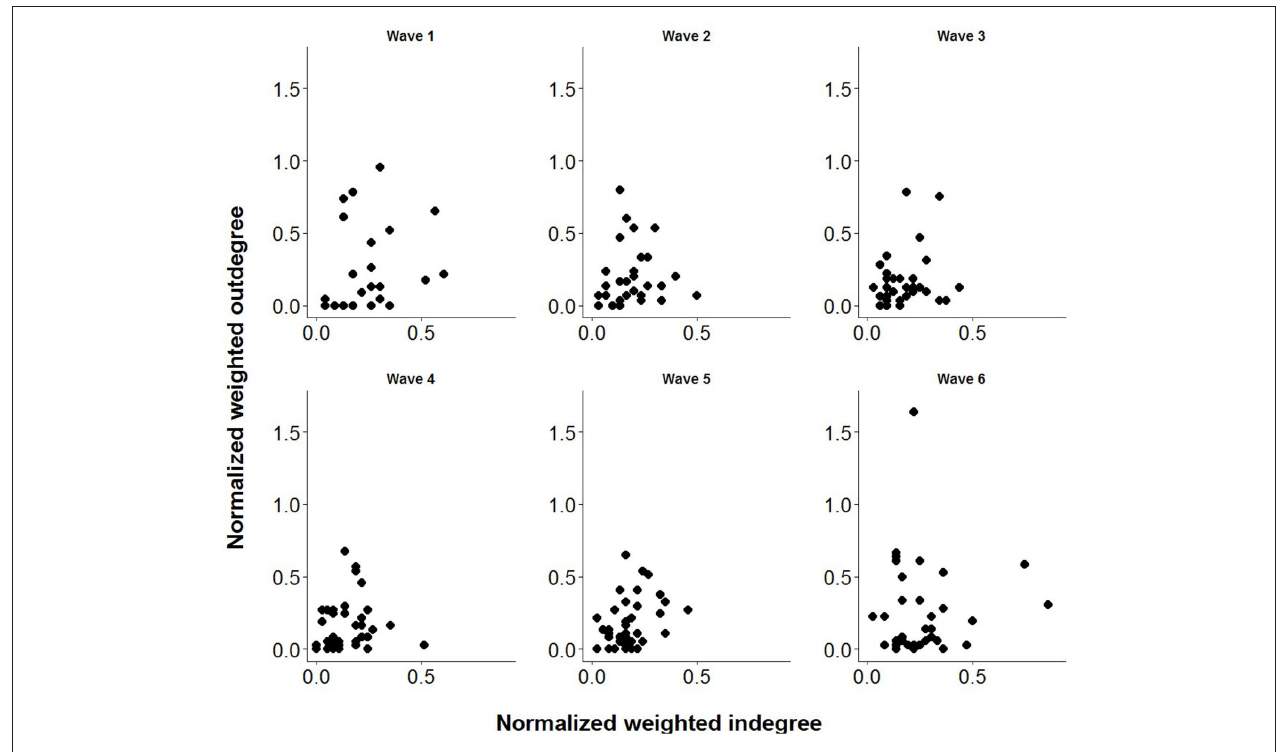
FIGURE 3 | Association between normalized weighted outdegree and indegree values of the cows for each wave